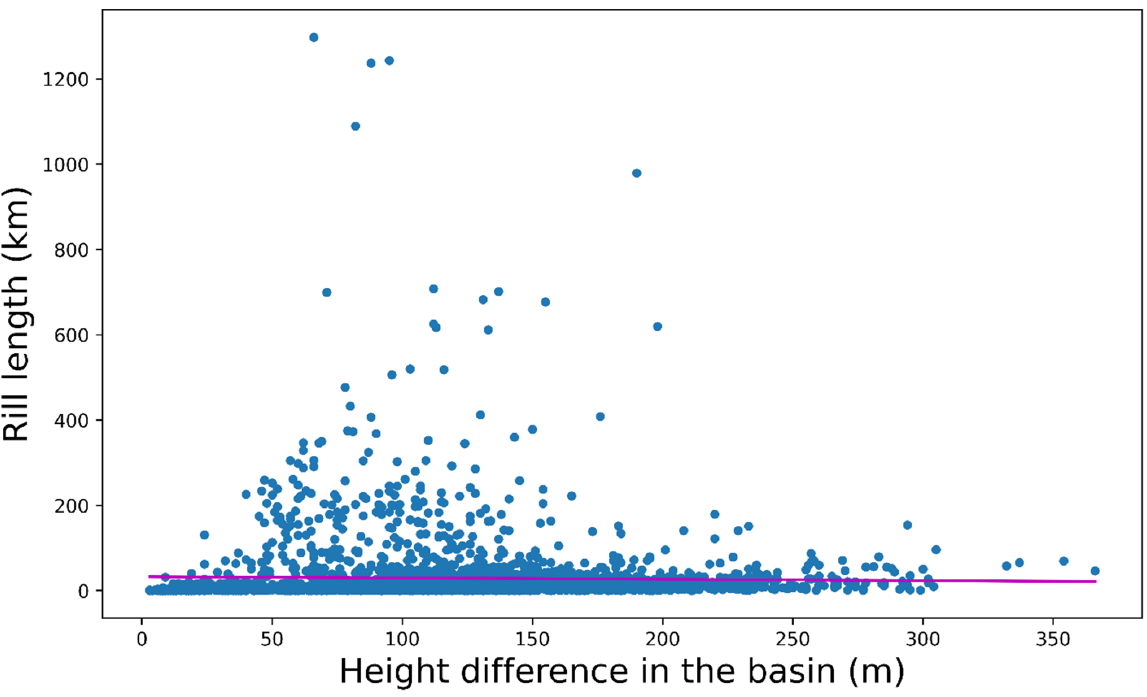
Figure 10. Linear relation of the total length of rill erosion to the elevation variation in the basin.